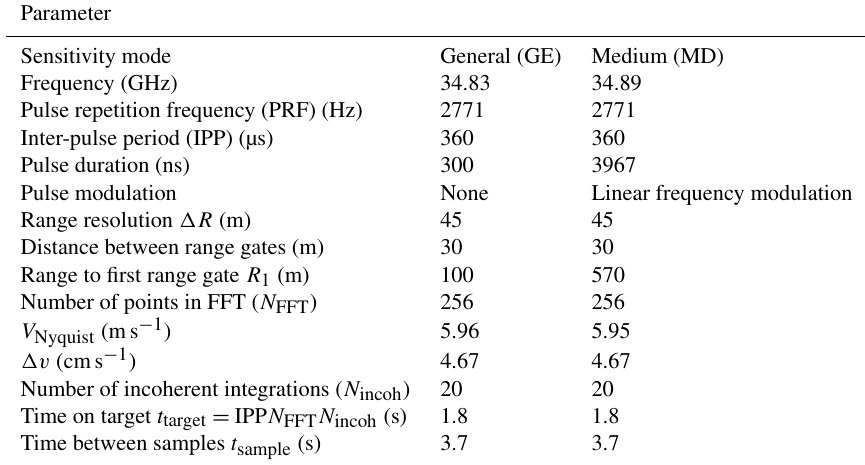
Table 1. Operating parameters for KAZR deployed at ARM Southern Great Plains (SGP) during 2018 and 2019. Operating modes included general purpose (GE) and medium sensitivity (MD) modes. Tabulated parameters include: pulse repetition frequency (PRF) (Hz), inter-pulse period (IPP) (µs), number of points in FFT ( N FFT ), number of averaged spectra (also known as number of incoherent integrations) ( N incoh